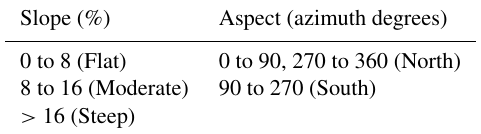
Table 2. Slope and aspect.